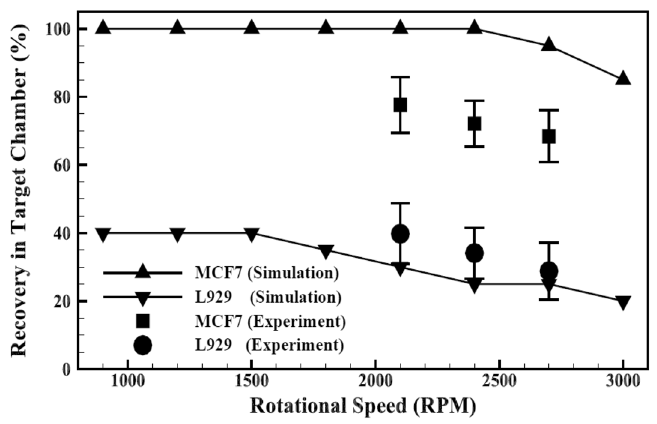
Figure 9. Numerical and experimental recovery rates of MCF-7 and L929 cells from the target chamber of the passive design of separator.